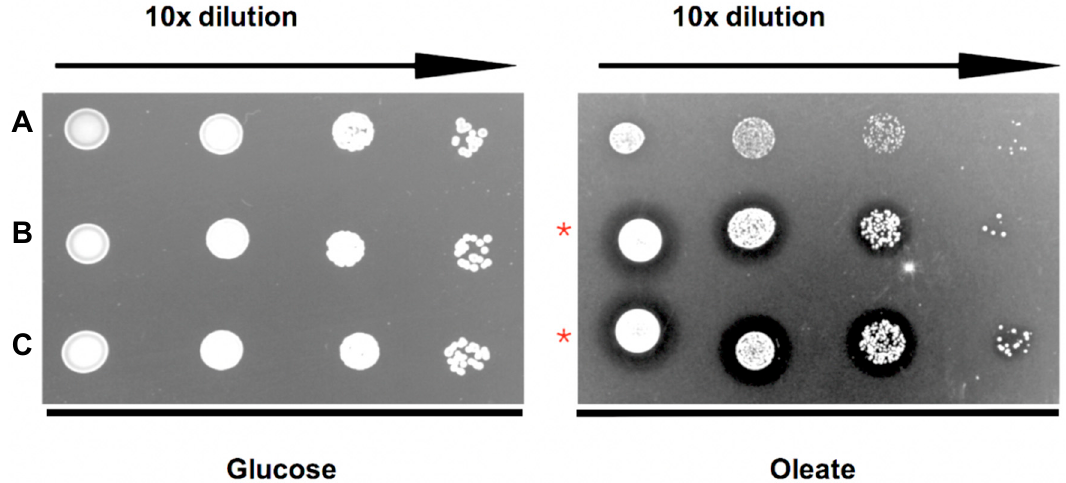
Figure 4. Tg Pex5 expression complements the growth defect of yeast ∆ pex5 mutant cells on oleic acid media. ( A ) Empty vector negative control; ( B ) Sc Pex5 positive control; and ( C ) Tg Pex5. 10-fold dilutions (from the left) spotted onto either glucose and oleate plates. As expected, all strains grow well in the presence of glucose. On oleate medium, the growth of the ∆ pex5 mutant transformed with the empty vector control is affected. In contrast, ∆ pex5 mutant cells transformed with plasmids coding for either Sc Pex5 ( B ) or Tg Pex5 ( C ) showed enhanced growth and a halo that is characteristic of efficient oleate utilisation and peroxisomal oxidation (red stars).